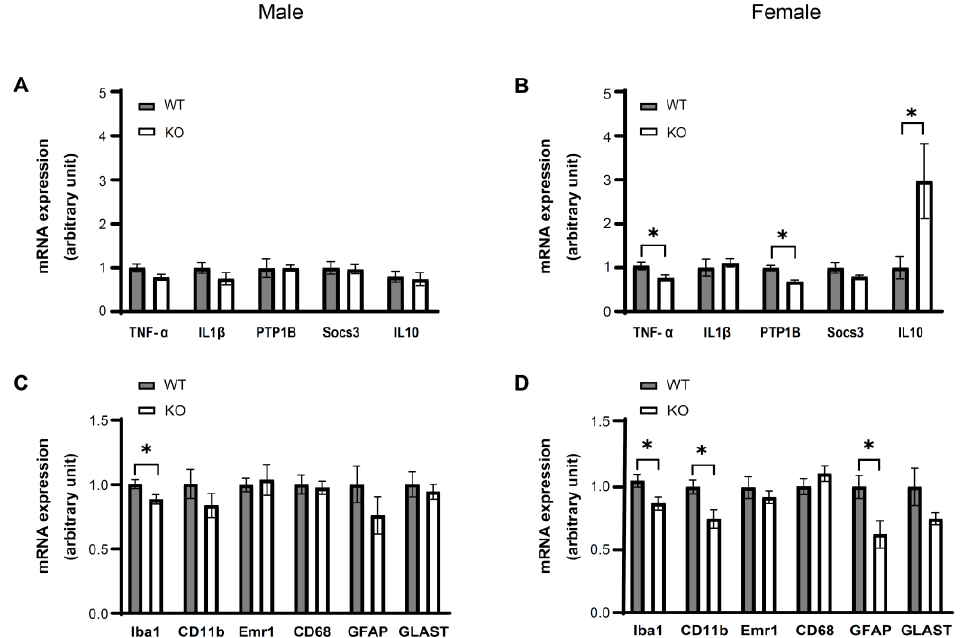
Figure 5. IKK β deficiency in the dopamine neurons of VTA suppresses inflammation in the VTA caused by HFD feeding for 4 weeks in mice. ( A – D ) The TNF- α , IL1 β , PTP1B, Socs3, IL10 ( A , B ) and Iba1, CD11b, Emr1, CD68, GFAP, GLAST ( C , D ) mRNA expression levels of male ( A , C ) and female ( B , D ) WT and KO mice on HFD for 4 weeks. Data are mean ± SEM. Unpaired t test was used for statistical analysis of A to D. * p < 0.05, versus WT. The details of statistics are shown in Table S2.